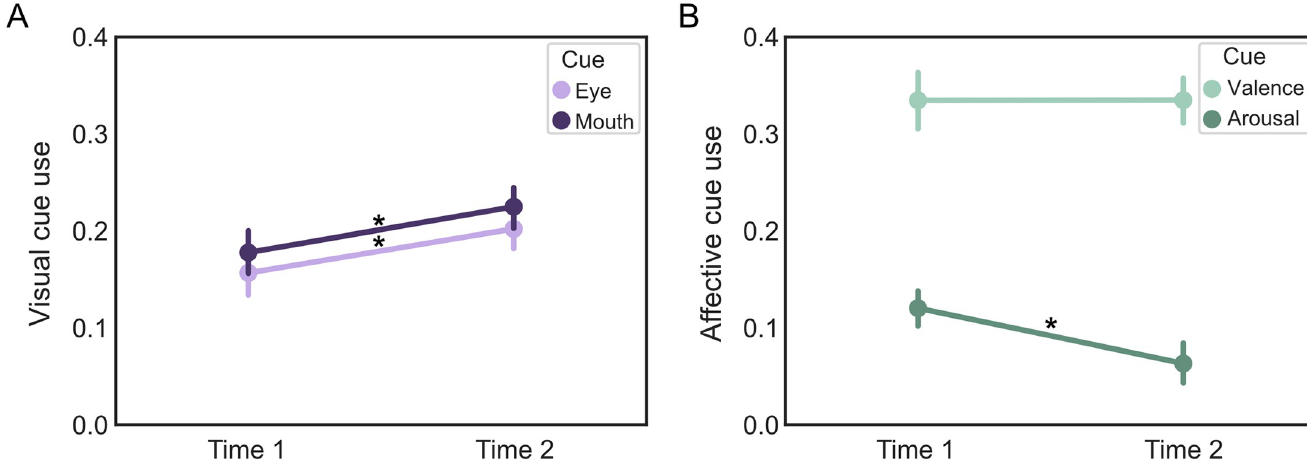
Fig 5. Change in facial cue use between time 1 and time 2 in Study 2. A) Eye and mouth cues use increased from time 1 to time 2. B) Arousal cue use decreased from time 1 to time 2. � p < 0.001. Error bars represent 95% confidence intervals. Created using the seaborn package (v0.10.0) for Python (v3.7.6).